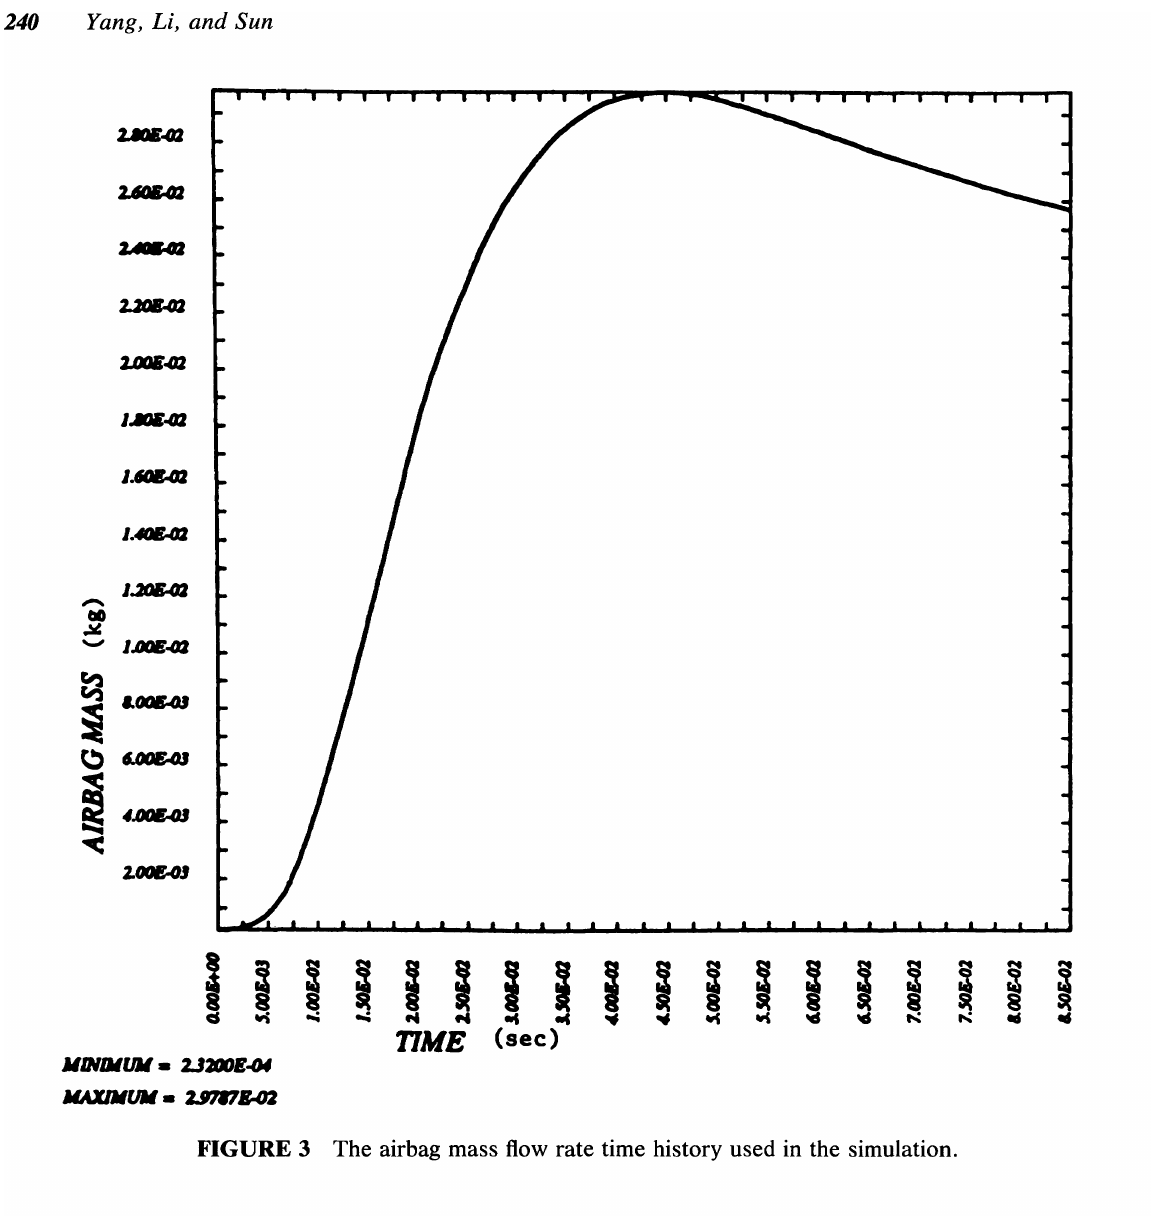
FIGURE 3 The airbag mass flow rate time history used in the simulation.